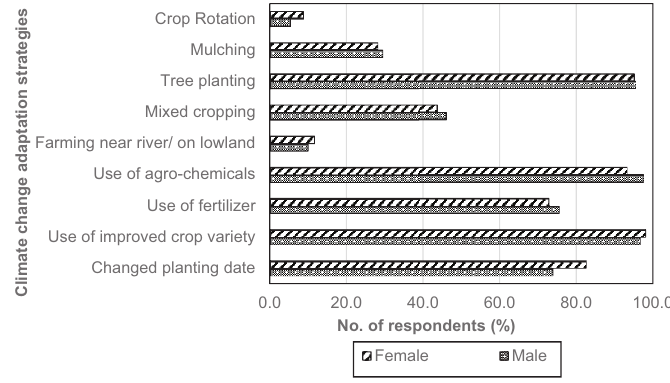
Figure 8. Adaptation